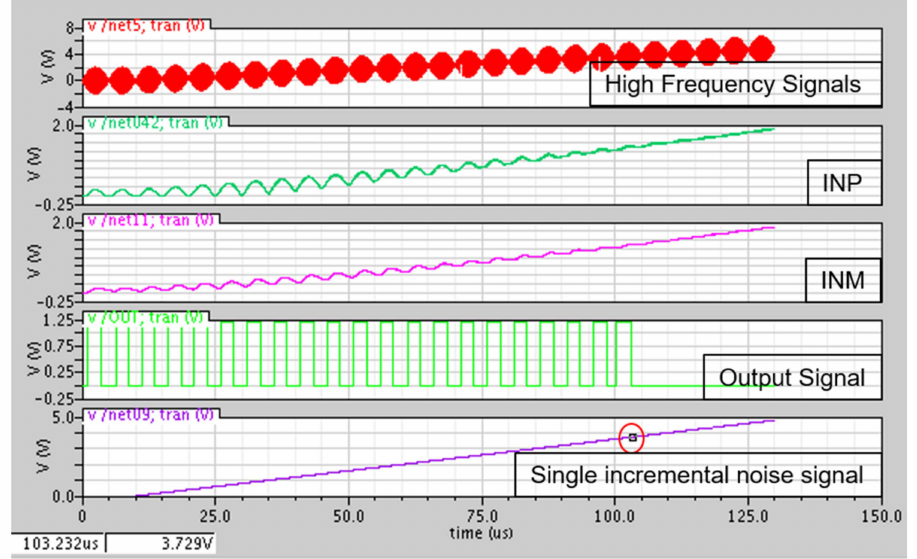
Figure 13. Simulation performance